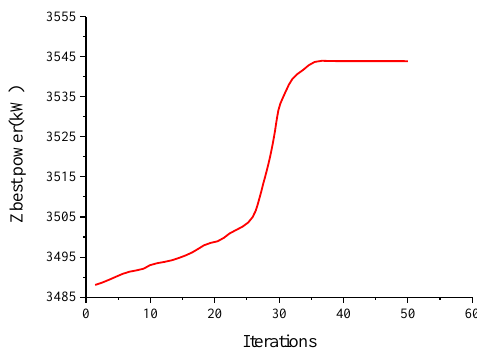
Figure 16. Evolution of particle swarm at mid-low wind speed.